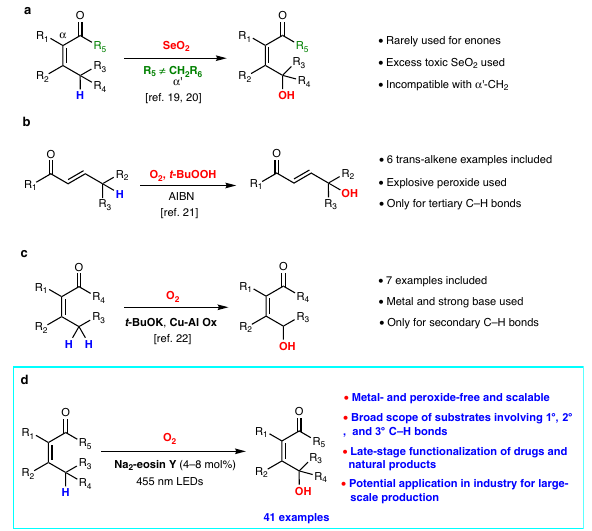
Fig.1|Methodsforhydroxylationof γ -C – Hbondsofenones.a Rileyoxidationof enones. b γ -Hydroxylation of tertiary C – H bonds of enones. c γ -Hydroxylation of secondary C – H bonds of enones. d This work: γ -Hydroxylation of primary, sec- ondary and tertiary C – H bonds of enones. AIBN azodiisobutyronitrile. Cu-Al Ox copper – aluminum mixed